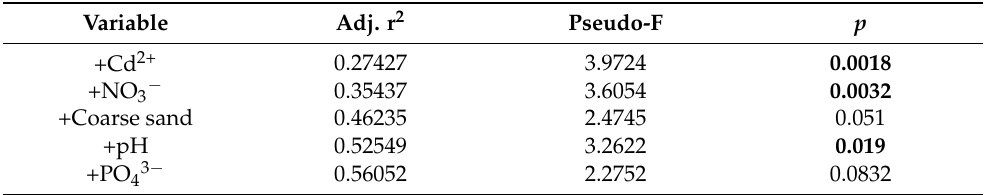
Table 4. Variables selected by distLM as the most affecting biological data showed in their cumulative contribution to total variation Adj, r 2 , and the significance ( p in bold) of their own pseudo-F value. Variable Adj. r